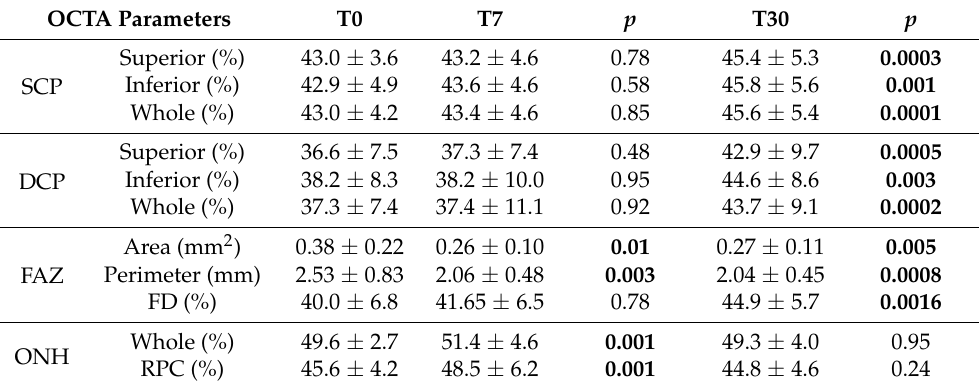
Table 2. Summary of all OCTA parameters in the treated eye at baseline (T0), one week after surgery (T7) and one month after surgery (T30). All parameters are presented in mean value ± standard deviation. In bold significant